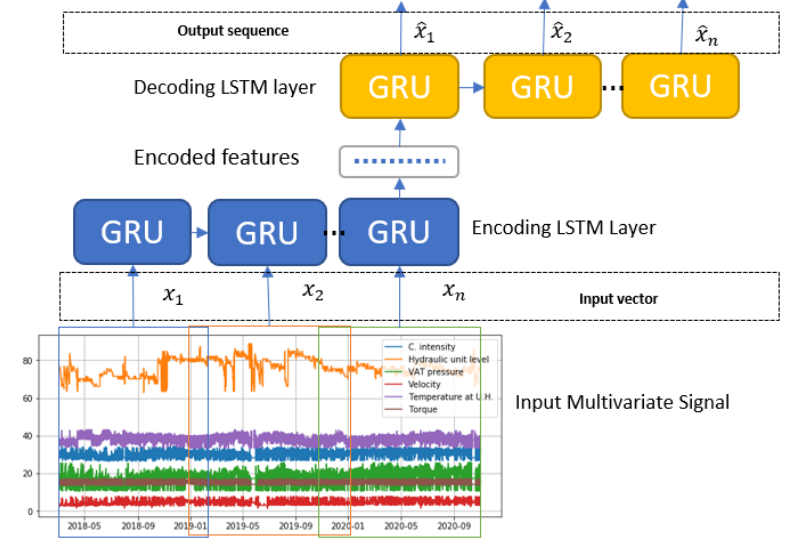
Figure 9. Base architecture of the GRU model